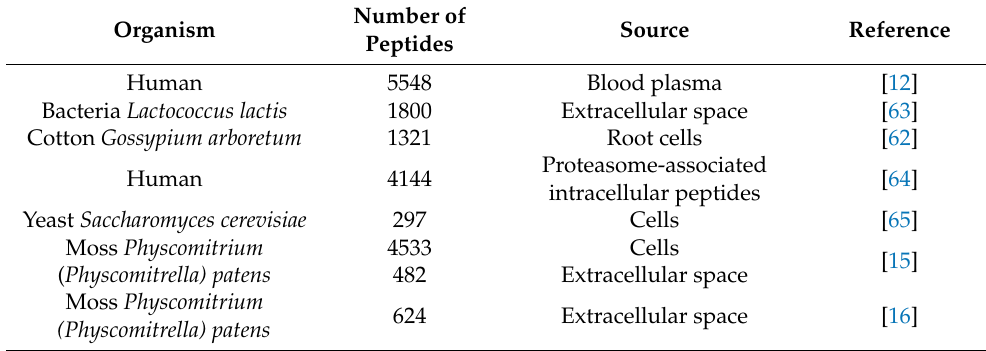
Table 1. Peptidome datasets selected for